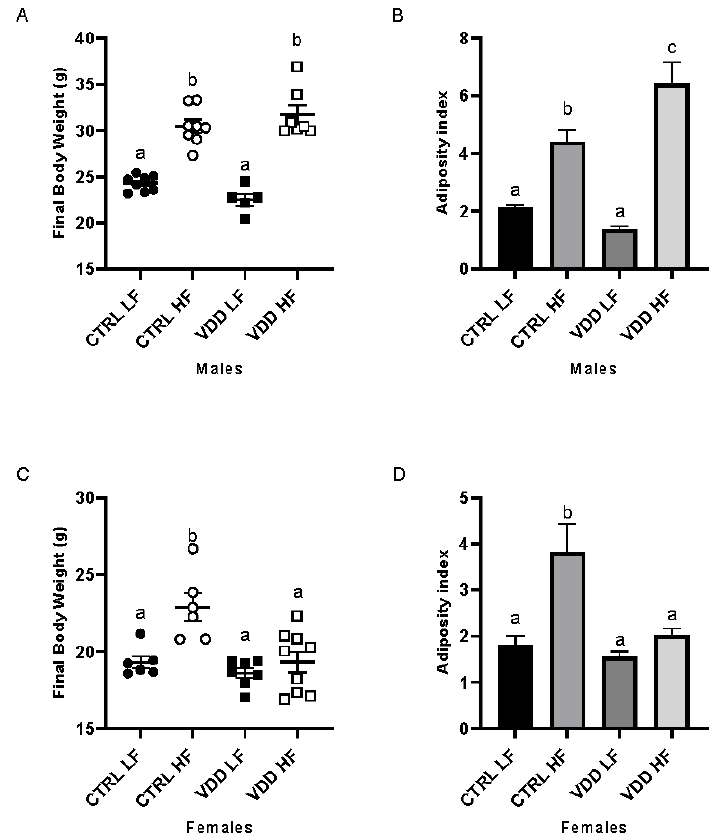
Figure 1. Body weight and adiposity index in males and females offspring. Body weight measured at the protocol end for the males and females offspring ( A , C ). Adiposity index of the offspring has been established for males and females ( B , D ). Values are presented as mean ± SEM. Bars not sharing the same letter were significantly different in Fisher’s LSD post hoc test. p < 0.05.